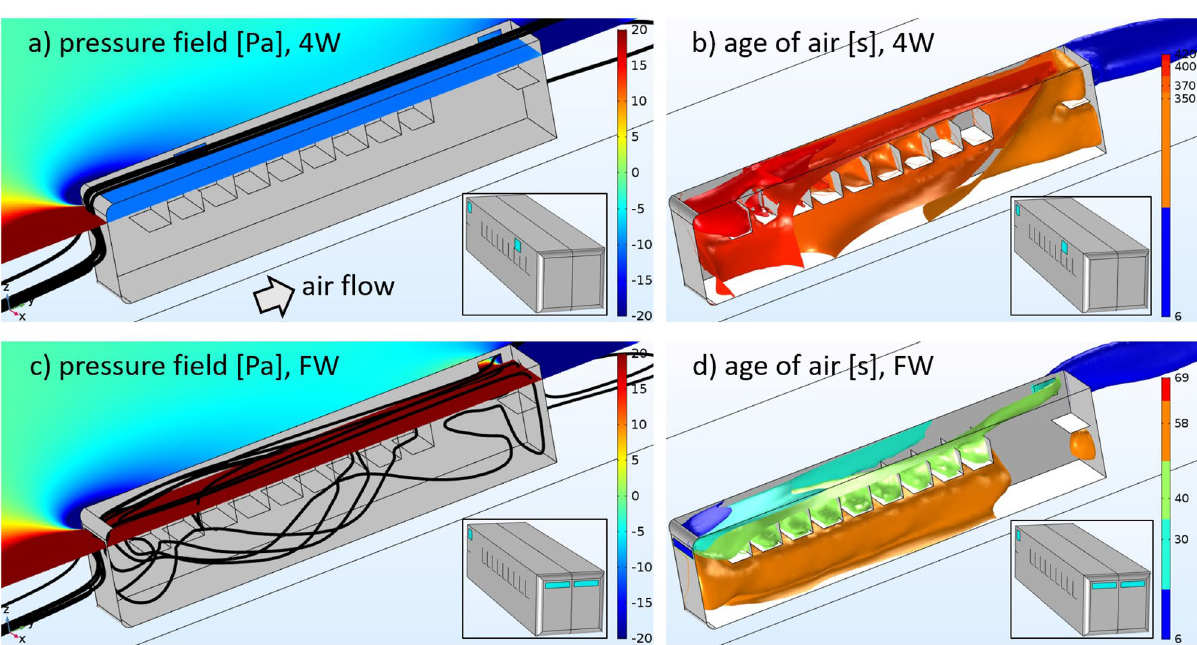
Figure 3. 3D simulations: pressure field, streamlines (black lines) and mean age of air for the 4W and FW configurations (see also the insets as a guide). Air flow direction is indicated with an arrow; the roof of the bus is not shown to facilitate the view